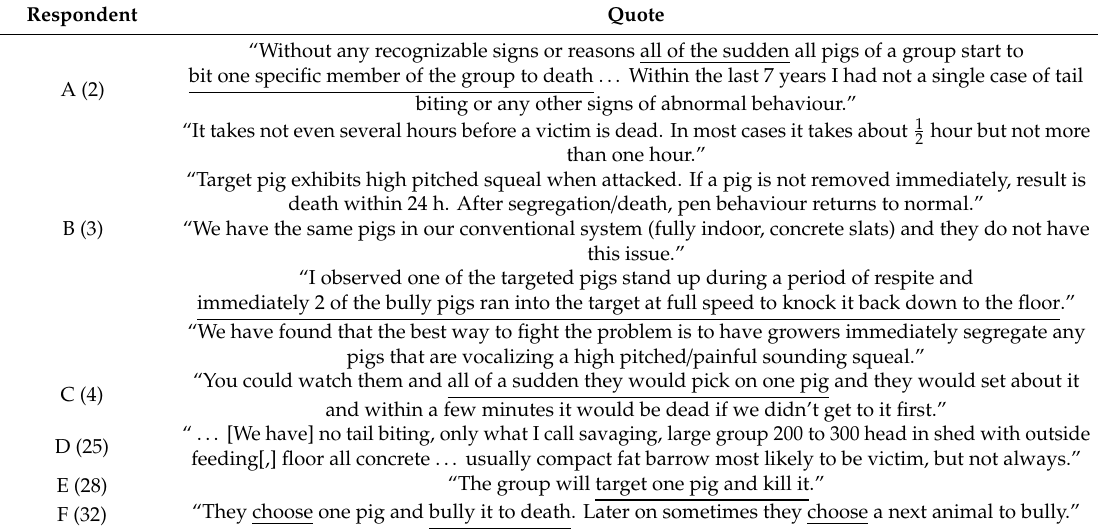
Table A2. Quotes from the respondents in the open questions about lethal gang aggression. The underlining is annotated by the